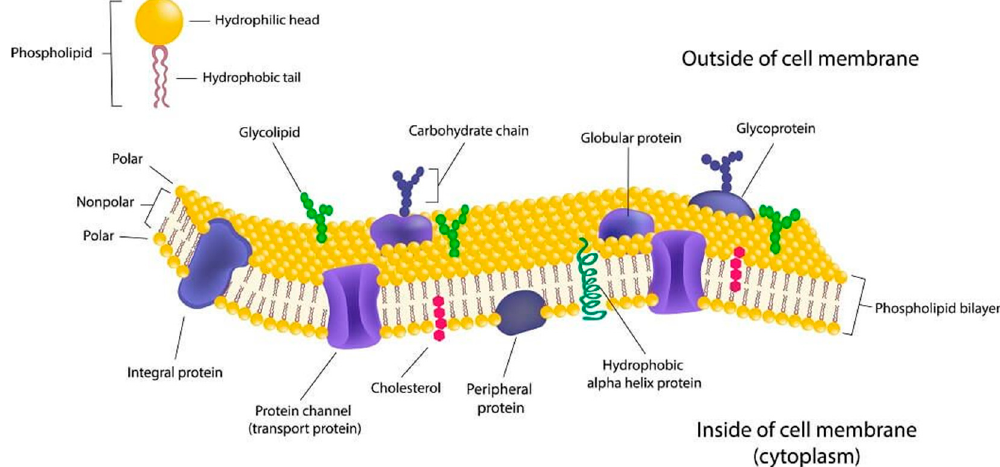
Figure 1. Cell membrane structure and its components (https://biologydictionary.net/cell-